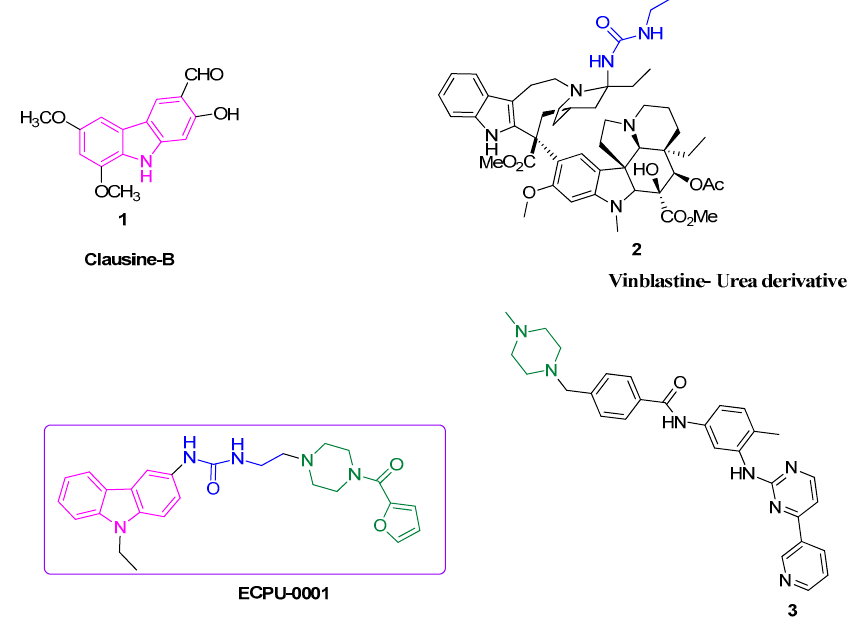
Figure 1. Potent anticancer molecules in preclinical or clinical trial studies and designed novel hybrid small molecule ECPU-0001.